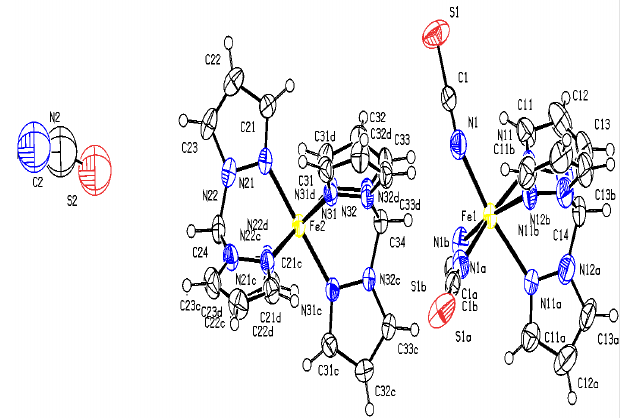
Figure 7. Unit of [Fe(HC(pz) 3 ) 2 ][Fe(HC(pz) 3 )(NCS) 3 ]NCS·2H 2 O.